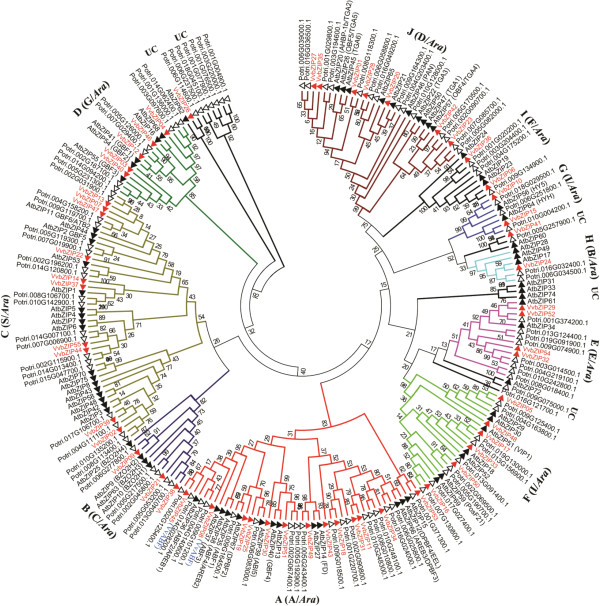
The phylogenetic tree of grapevine and Arabidopsis bZIP genes. The 55 grapevine, 72 Arabidopsis and 99 poplar bZIP domain protein sequences were aligned by Clustal X 1.83 and the phylogenetic tree was constructed using MGA5.0 by the Neighbor-Joining (NJ) method. The Bootstrap value was 1,000 replicates. The gene names of the characterized bZIP genes are shown in parenthesis after the gene numbers, and which were referred to previous research [2,4]. A(A/Ara), B(C/Ara) and so on is presented as the subfamily names of bZIP gene family in grapevine (capital letter outside the parenthesis) and Arabidopsis (capital letter in parenthesis and Ara represent for Arabidopsis), UC, unclassed genes or clades. The colored branch indicates the different subfamily and the black represent for UC.